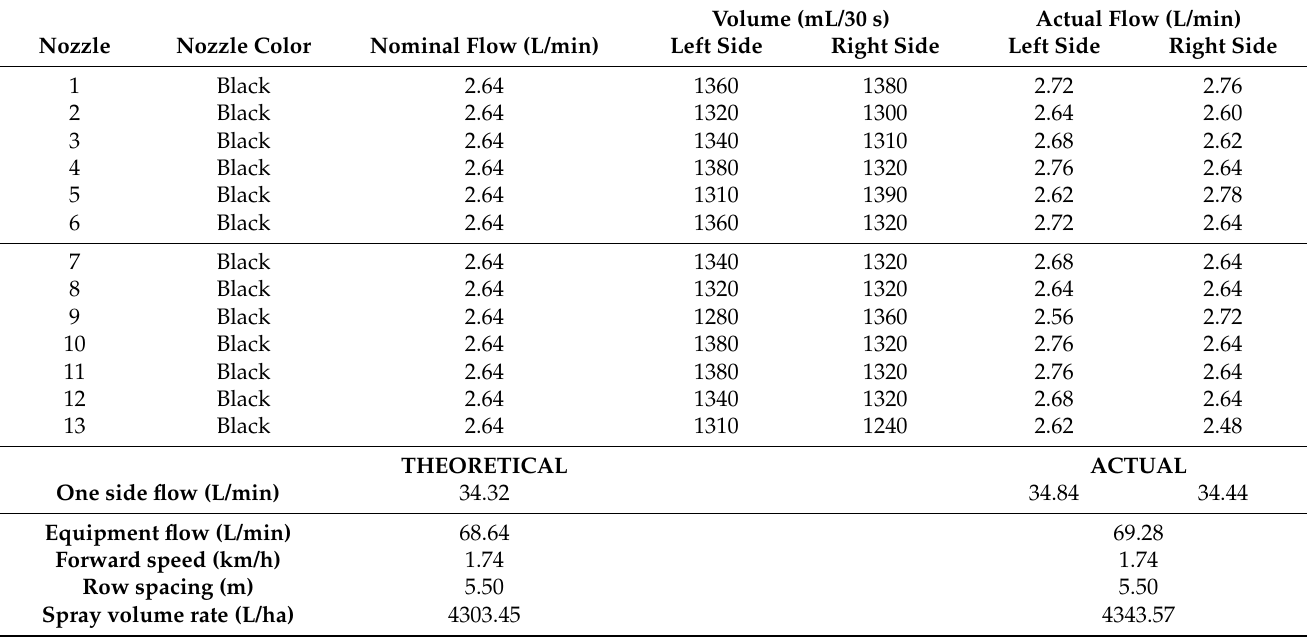
Table A12. Selection and calibration of nozzles for the C2 sprayer, with the following configuration: No adjusted to the vegetation/High & Low fan speed/High spray volume rate/Conventional nozzles (Fine)/Pressure: 9